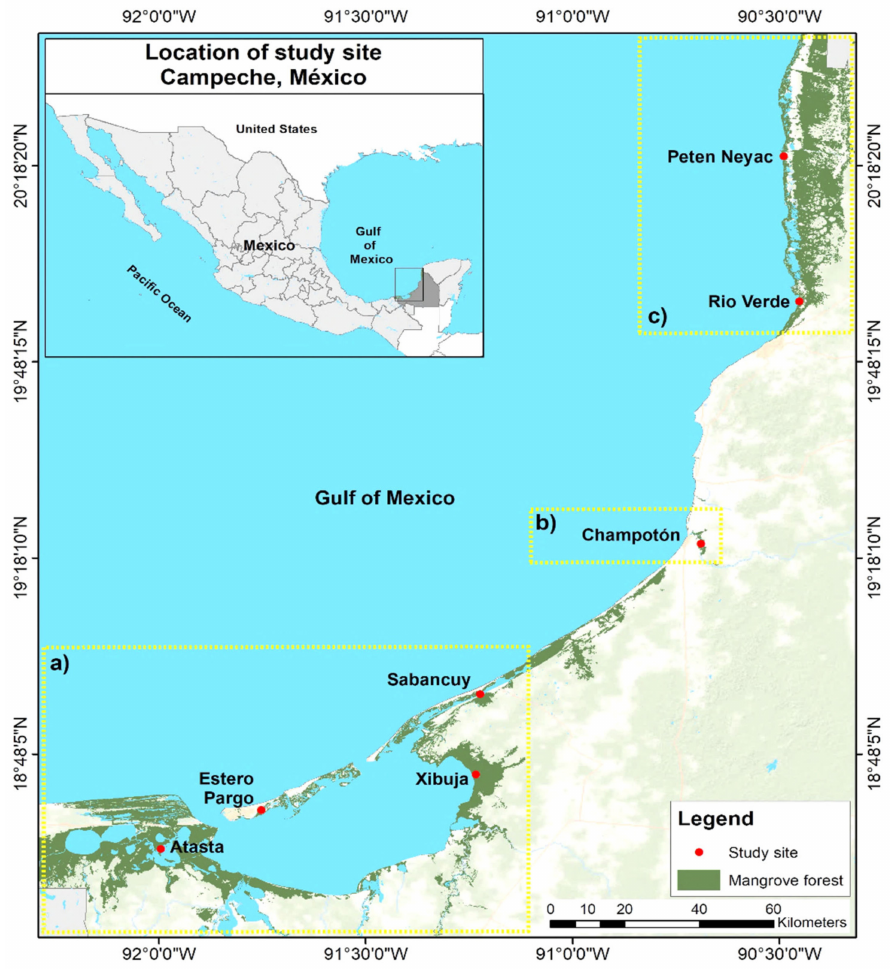
Figure 1. Map of the seven mangrove forests studied on the coast of Campeche, Mexico. ( a ) Laguna de Terminos, ( b ) Rio Champoton and ( c ) Los Petenes Biosphere